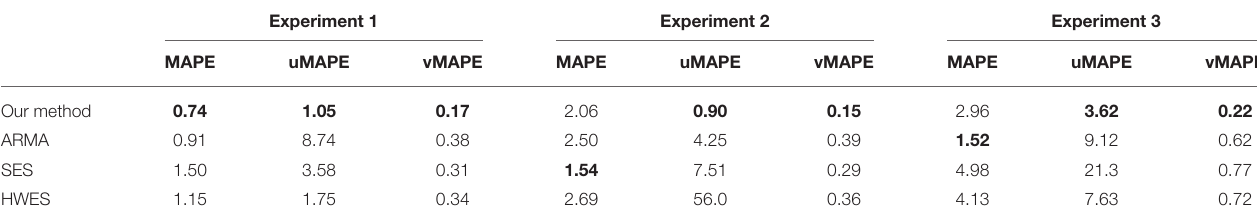
TABLE 1 | Comparison among forecasting methods.